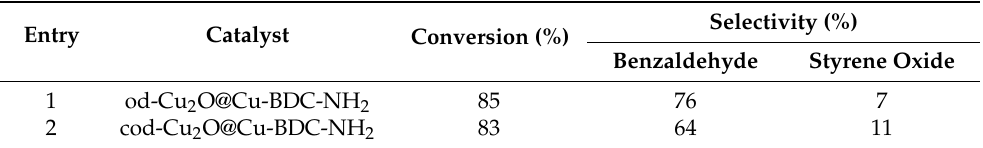
Table 4. Catalytic performance of od-Cu 2 O@Cu-BDC-NH 2 and cod-Cu 2 O@Cu-BDC-NH 2 in the selective oxidation of styrene a